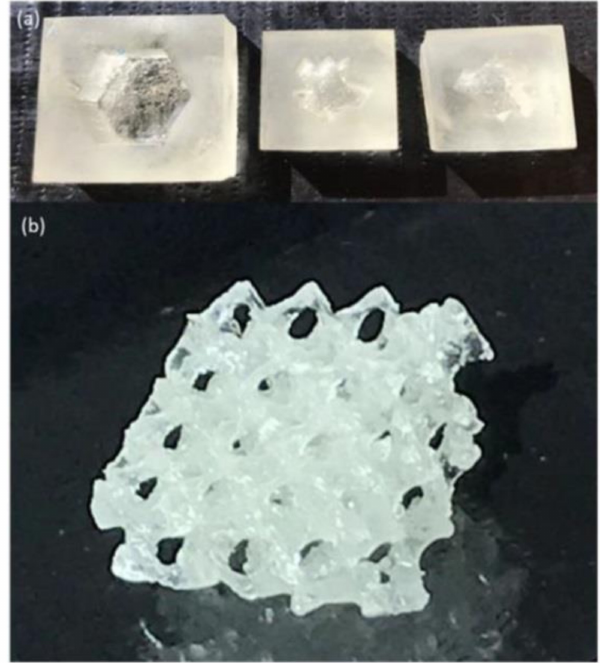
Figure 12. 3D printed models of polymyrcene resins for negative volume molds ( a ), and in porous 3D sca ff olds ( b ). (Reproduced from Reference 16, with permission from American Chemical Society).